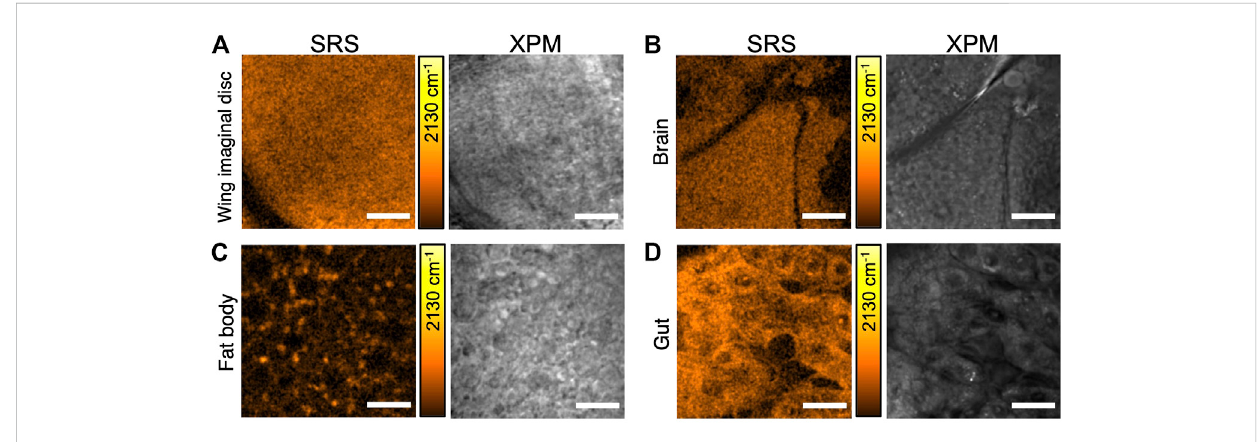
FIGURE 2 SRS imaging of d 8 -Met uptake in various Drosophila tissues. (A) larval wing imaginal disc, (B) larval brain, (C) larval fat body, and (D) adult gut. SRS images are shown (left side) with the corresponding background due to cross-phase modulation (XPM) (right side). The color bars corresponding to the d 8 -Met concentration shows maximum values of (A) 65 mM, (B) 40 mM, (C) 51 mM and (D) 37 mM. Scale bars 20 μ m (A, D) , 25 μ m (B, C)